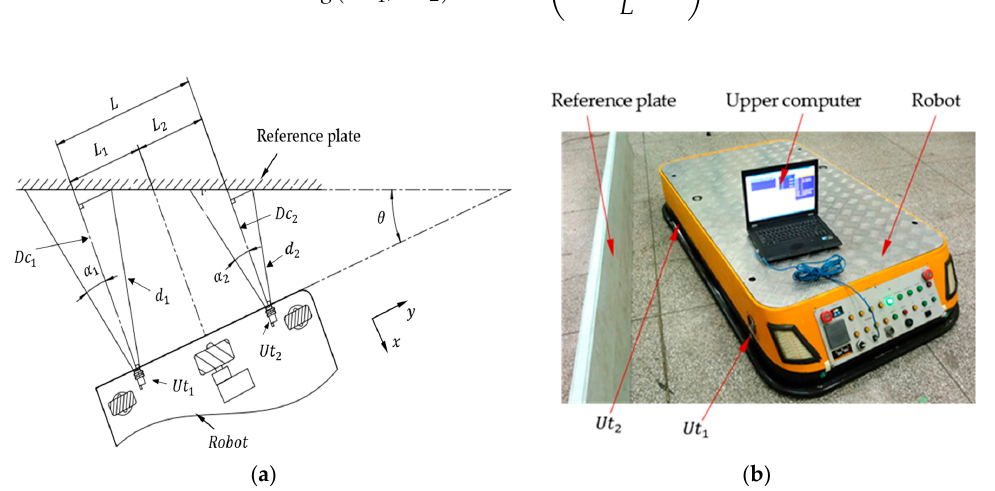
Figure 2. Lateral localization of a mobile robot. ( a ) The mathematical model of the localization application; ( b ) the practical application of lateral localization.